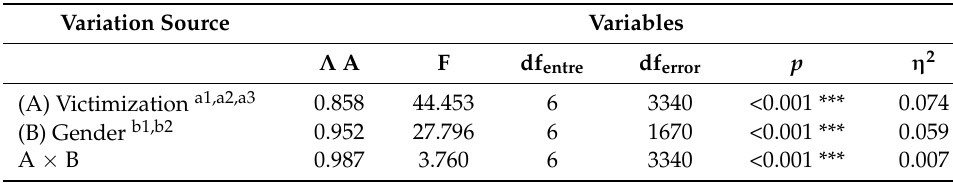
Table 3. MANOVAS by victimization and